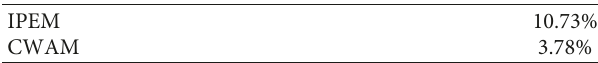
Table 12: Excitation 1’s relative errors of the root mean square value.